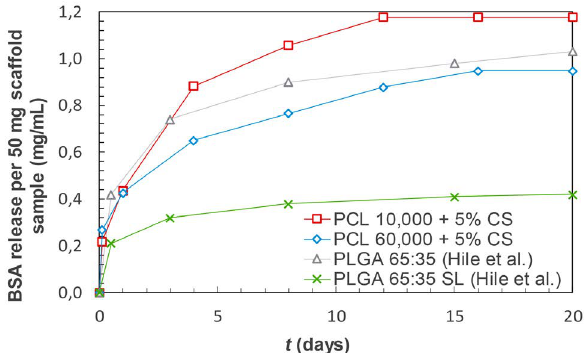
Figure 5. Total concentration of released BSA from PCL 10,000 + 5% CS and PCL 60,000 + 5% CS scaffolds vs. time of release, com- pared to the literature data.